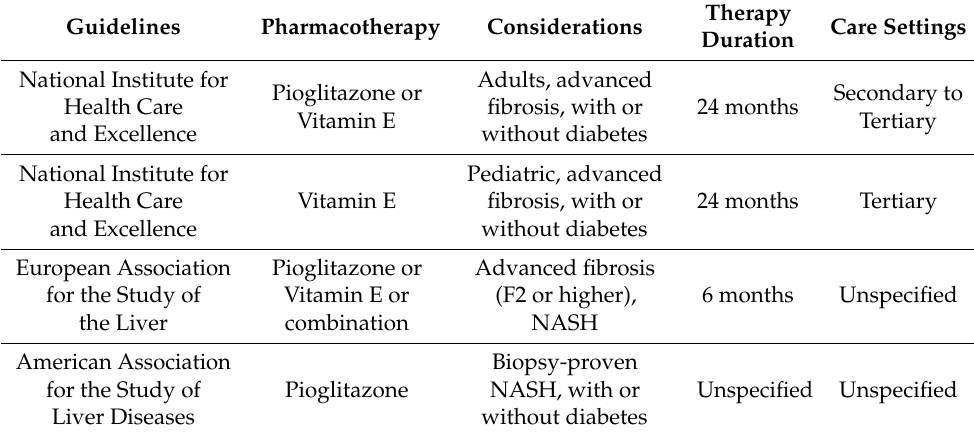
Table 4. Use cases of pharmacological treatment according to various guidelines globally (NICE, EASL, and